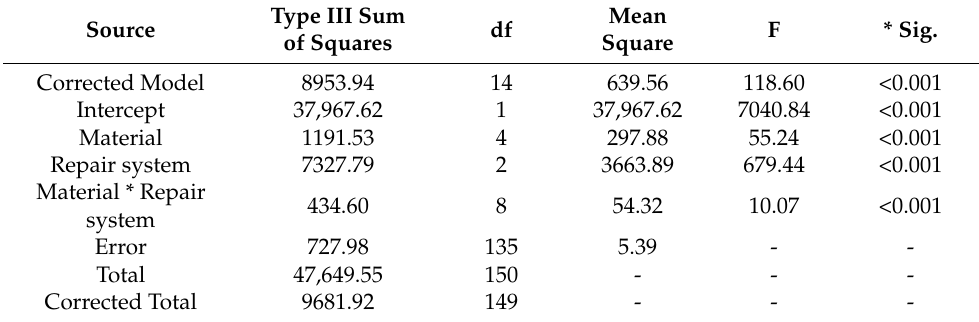
Table A1. Results of factorial ANOVA for shear bond